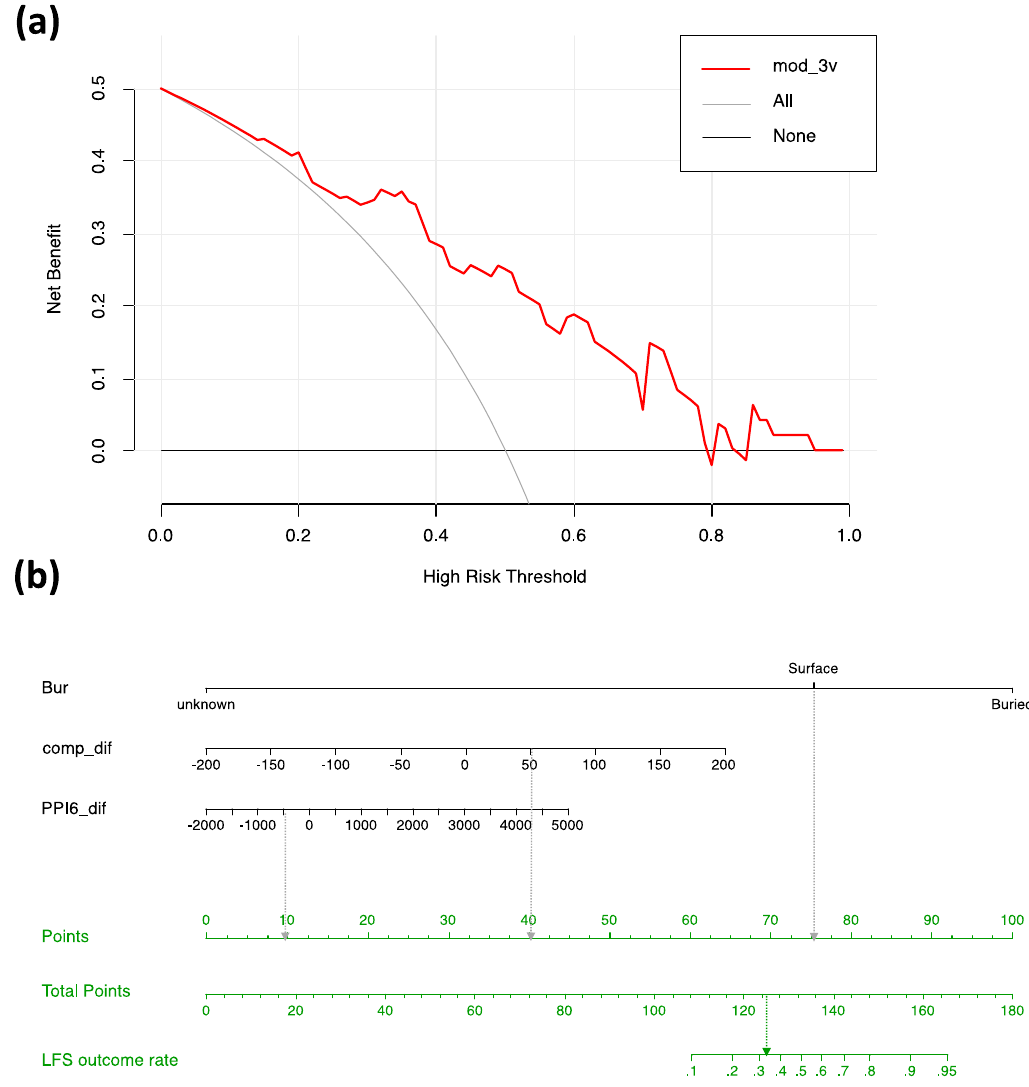
Figure 4. Potential for the most favored model. ( a ) Decision curve analysis of models for prediction of phenotypic outcome (LFS or HBC). The y -axis indicates the net benefit of using mod_3v model (red line). The thin gray line (All) shows net benefit values expected assuming all assessed variants are LFS. The darker gray line (None) shows net benefit values expected assuming no assessed variants are LFS. The net benefit for prediction of LFS variants is regarded as positive for probability values exceeding those for the “All” and “None” values. ( b ) The nomogram that facilitates manual estimation of the risk of LFS disease outcome using the mod_3v model. For the value of each explanatory variable the equivalent value on the “Points” scale is assessed. The sum of all Points values is then located on the “Total Points” scale (middle green row) so that the corresponding probability value can be read from the “LFS outcome rate” scale (upper green row). The dotted arrows show a hypothetical example for a surface residue with a comp_dif value of 50 and a PPI6_dif value of − 500, for which the equivalent “Point” values (10, 40 and 75) summate to 125 (“Total Points”), giving a LFS outcome risk of slightly over 0.3.